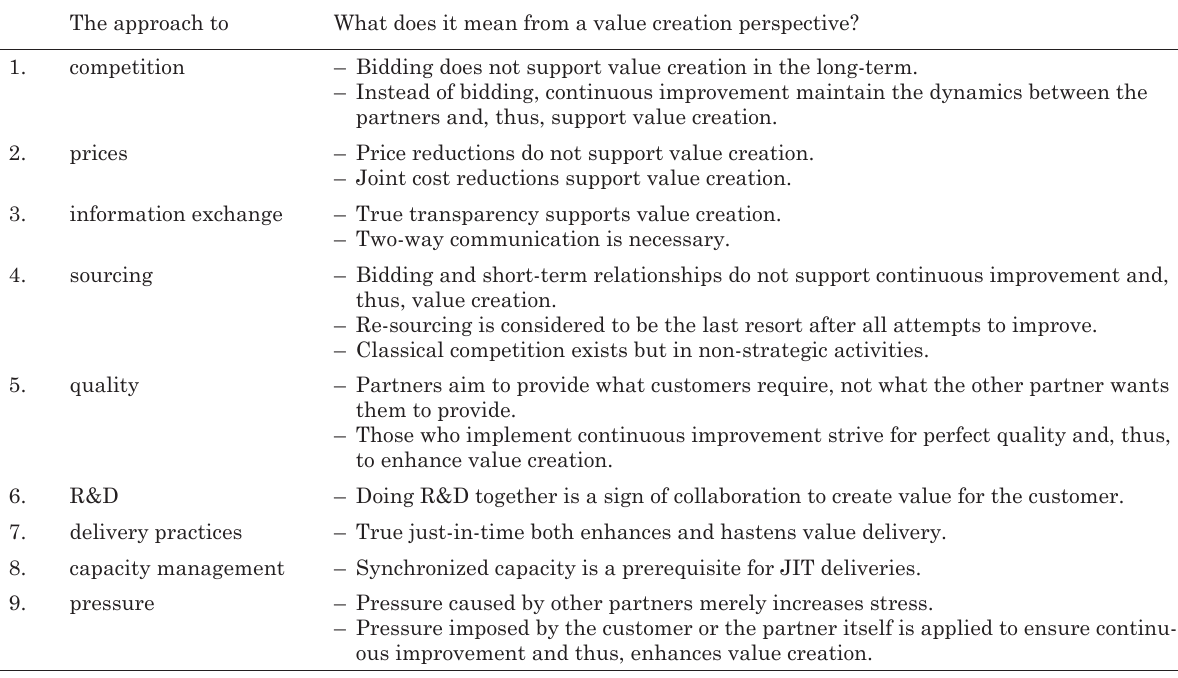
Table 1. The role and nature of the nine factors in the lean partnering from value creation perspective (adapted from Lamming